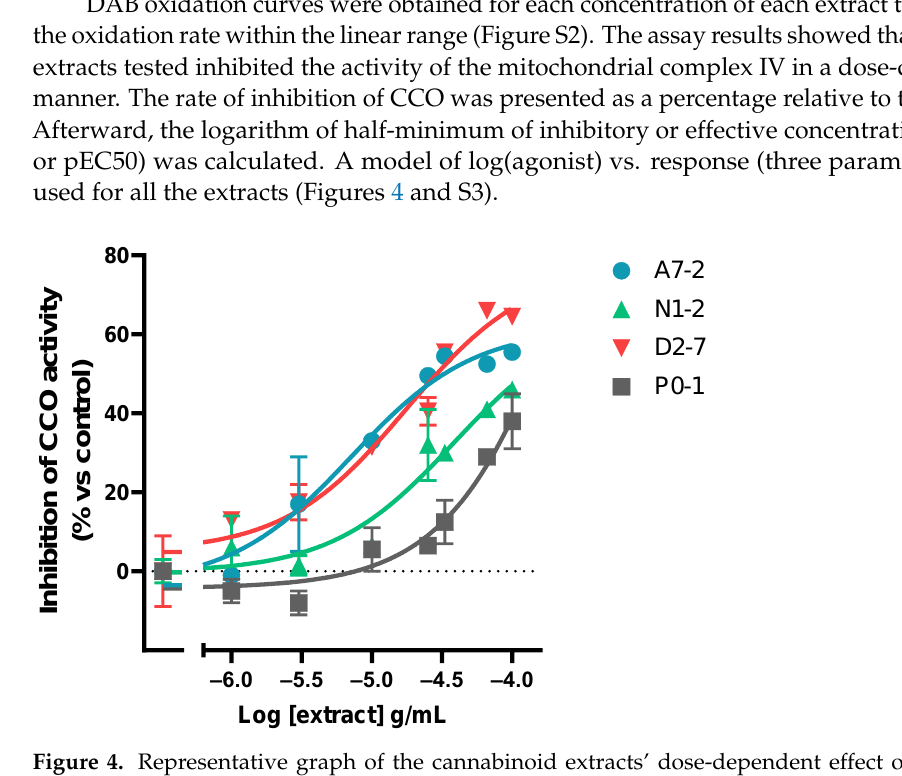
Figure 3. Analysis workflow. Sample separation for selected variables and confusion matrices for kNN, RF, and NB models.